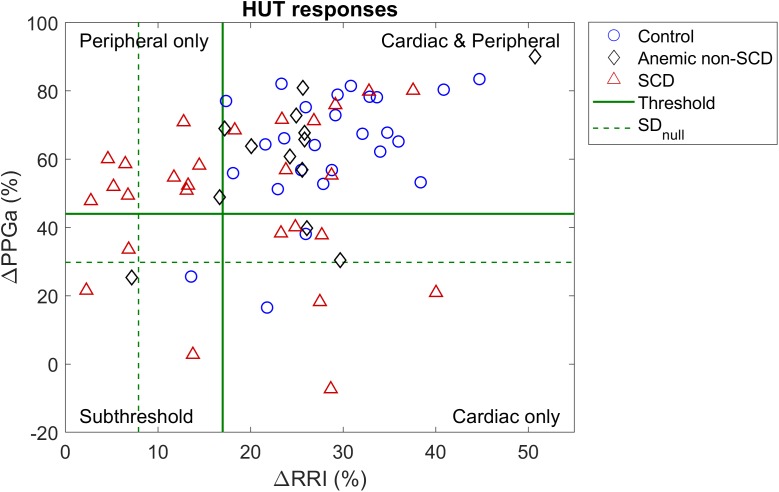
Scatter plot of percent mean change in RRI and PPGa during HUT relative to supine value. Dash lines (SDnull) represent the level of spontaneous fluctuations during supine in RRI and PPGa. Solid lines are the optimal thresholds that divide subjects into clusters of different HUT response phenotypes. Most subjects were classified into the dual cardiac and peripheral response phenotype (CP, upper right quadrant). However, the peripheral vasoconstriction only phenotype (P, upper left quadrant) consisted of mainly SCD subjects.